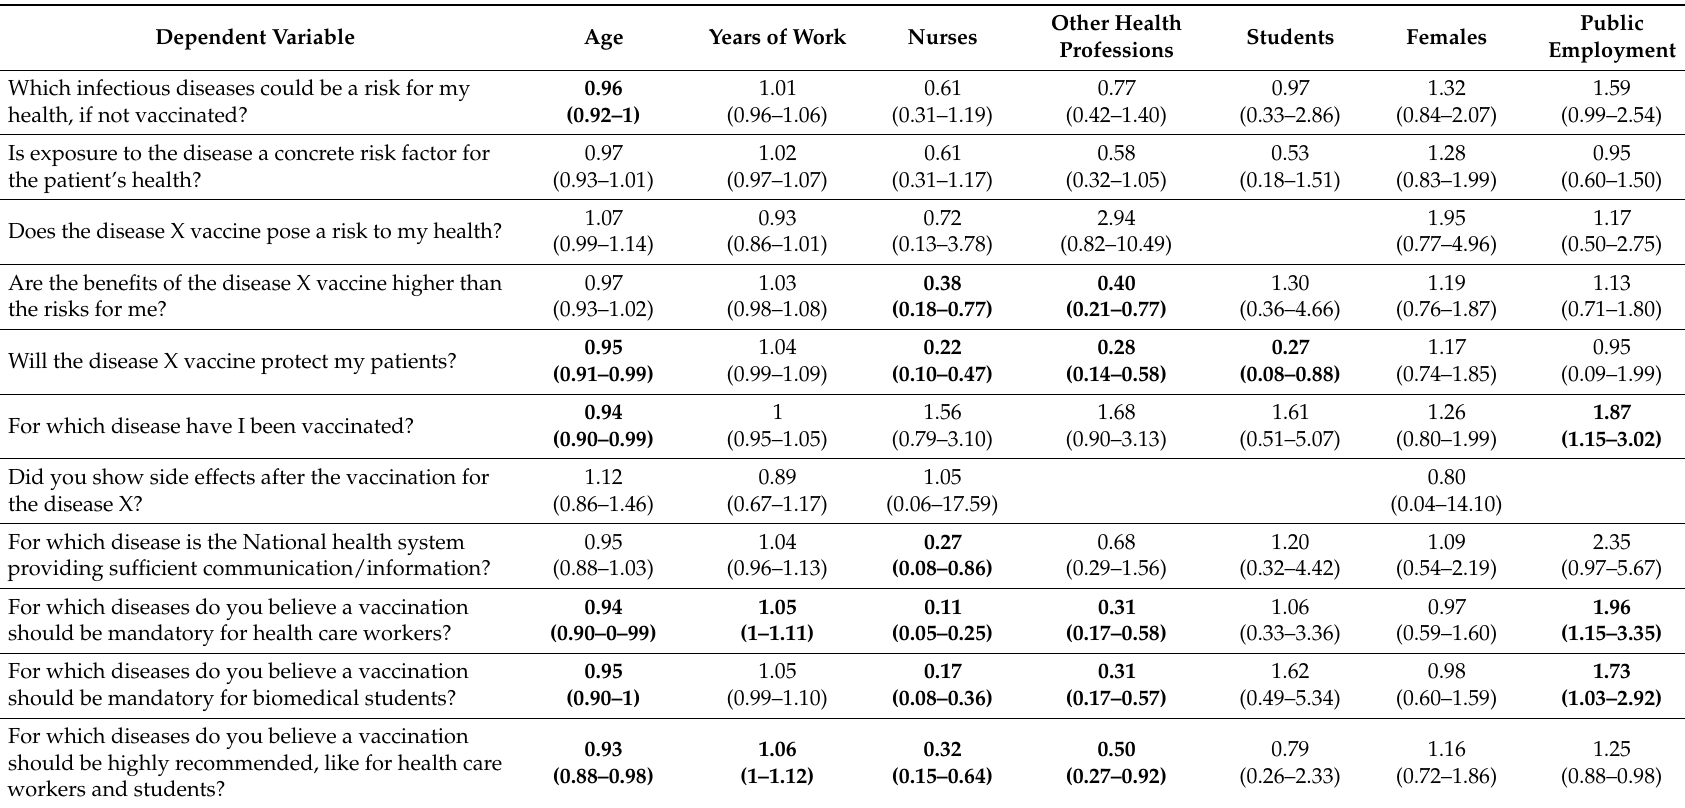
Table 9. Results of the multivariate analysis considering